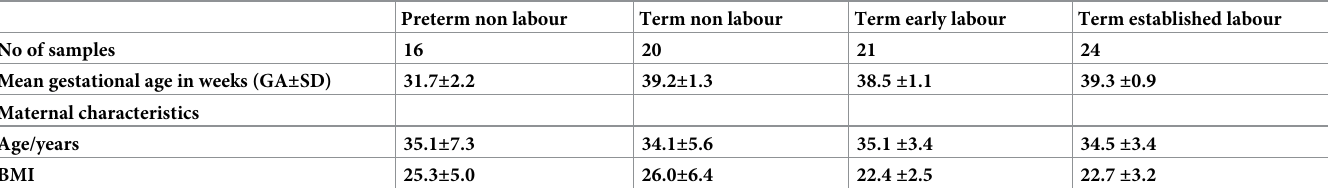
Table 1. Demographic data for term myometrial tissue samples collected.